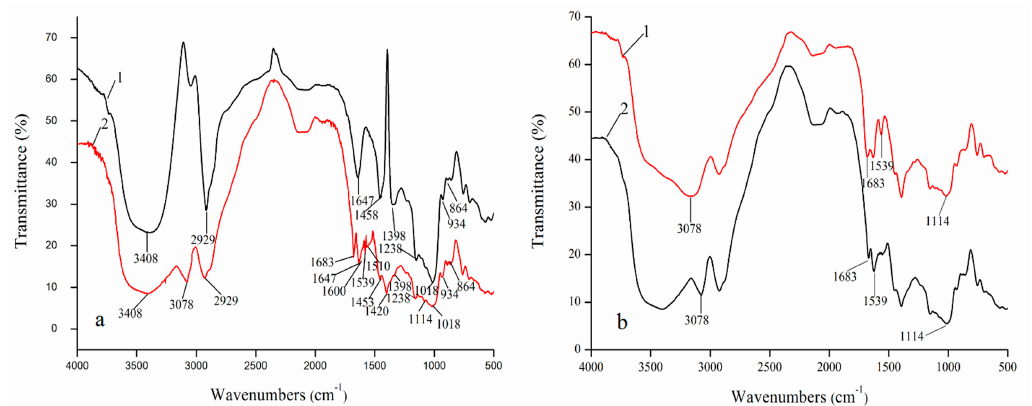
Figure 1. ( a ) FT-IR spectra of xylan (spectrum 1) and CAX (spectrum 2, sample 17 in Table 1); ( b ) FT-IR spectra of CAX with different DSs (spectrum 1, sample 17; and spectrum 2, sample 18).